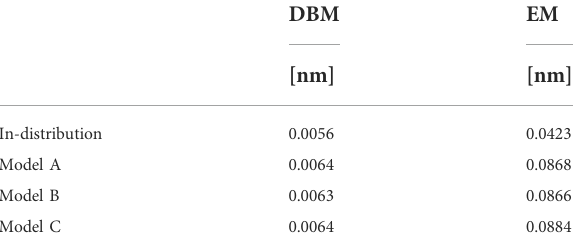
TABLE 2 Jensen-Shannon divergences for in-distribution and generalization test sets computed between backmapped